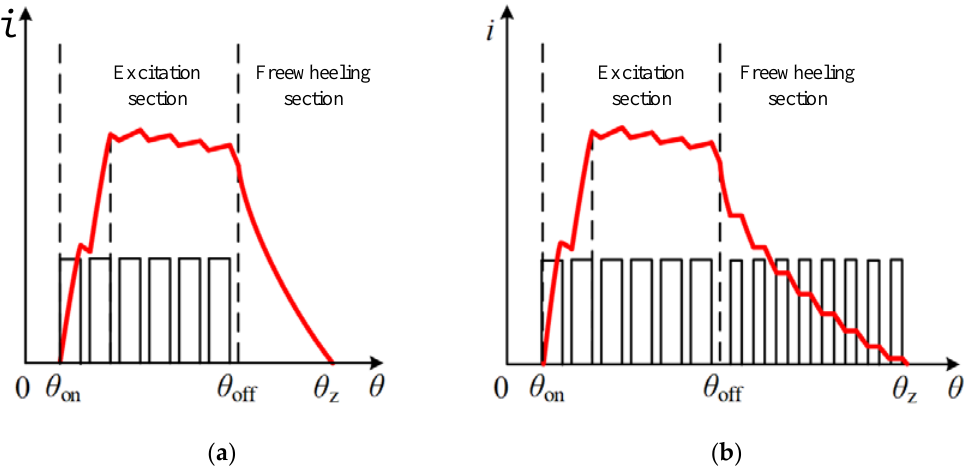
Figure 8. One phase waveform of chopper control: ( a ) current waveform of the excitation section and ( b ) current waveform of the freewheeling section.